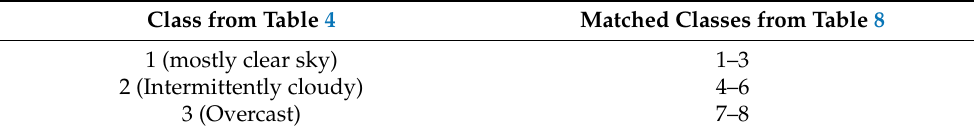
Table 9. Matched classes for